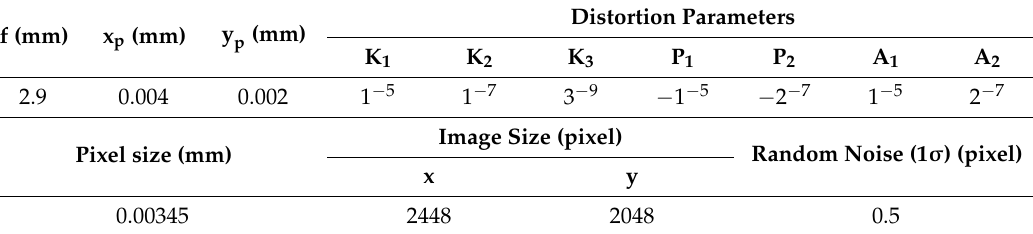
Table 3. Specification of camera in self-calibration simulation.